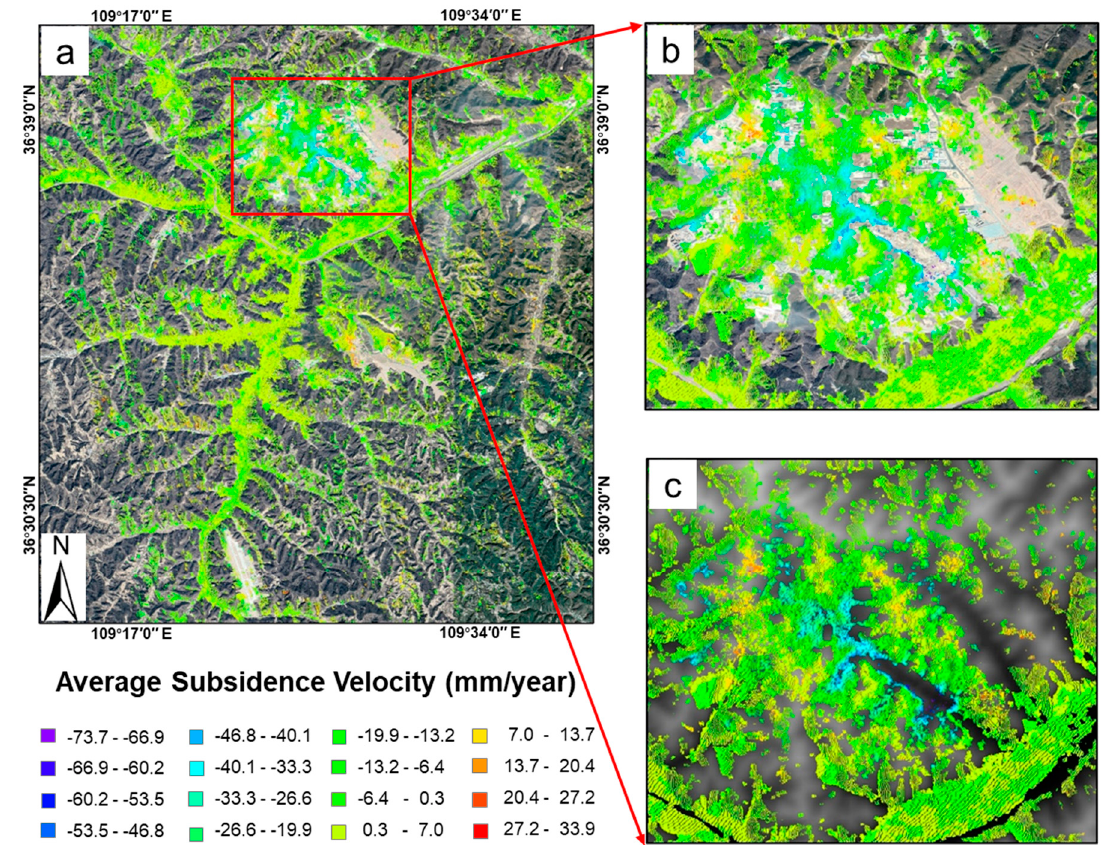
Figure 4. The average velocity of surface deformation in the Yan’an urban area. ( a ) The urban area of Yan’an superimposed on the Google Earth image. The detailed surface deformation of YND superimposed on ( b ) the Google Earth image and ( c ) SRTM data.